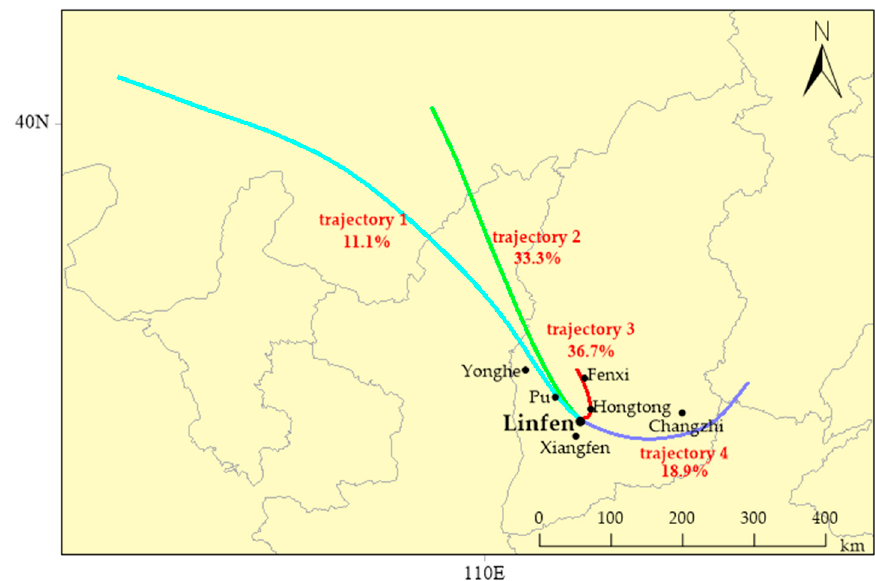
Figure 6. Result of cluster analysis of backward trajectory of airflow in urban Linfen from 16 to 25 January 2019.